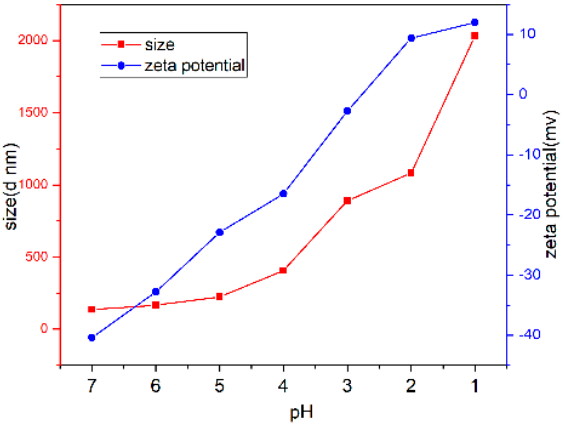
Figure 5. Size and zeta potential of polymeric micelles at different pH.